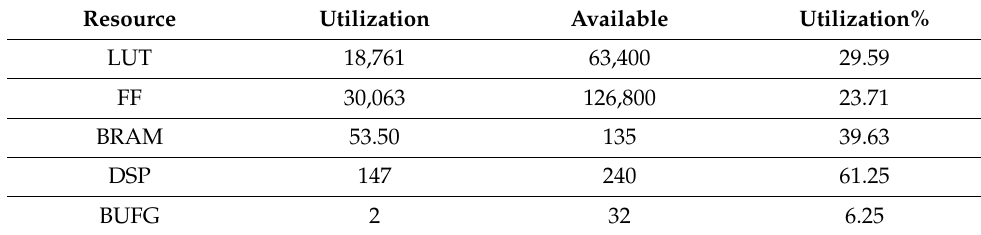
Table 5. Resource utilization in vivado synthesis